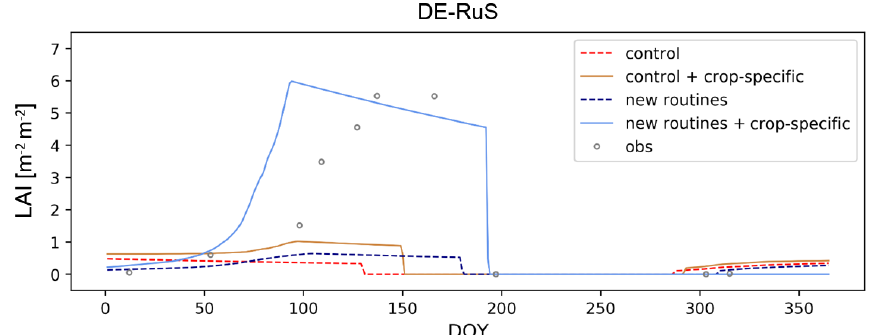
Figure 2. Daily simulation results for the LAI, simulated with default model and the default parameter set (control), the default model with new parameter set (control + crop-specific), the extended winter wheat model with default parameterization (new routines), and the extended model with the new parameter set (new routines + crop-specific), compared to point observations for a winter wheat year at